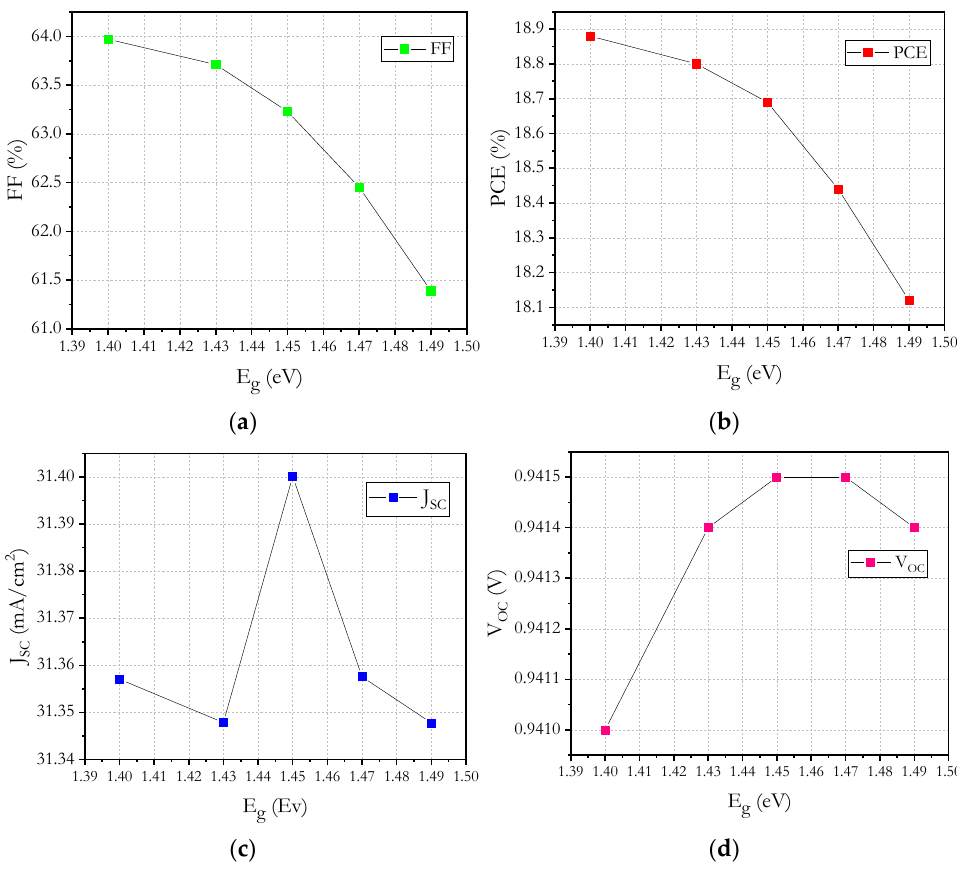
Figure 9. Kesterite band gap energy versus: ( a ) FF , ( b ) PCE , ( c ) J sc and ( d ) V oc .